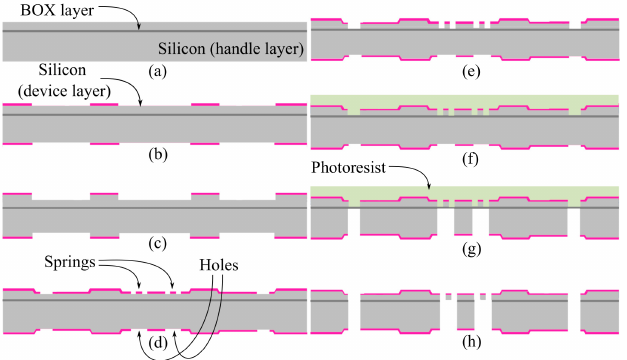
Figure 5. Fabrication process for the MEMS structures: ( a ) SOI wafer, ( b ) double-side alignment lithography, ( c ) device and handle DRIE process for the desired stiffness and mass weight, ( d ) lithog- raphy for the design of the springs in the device and proof mass design for the handle, ( e ) device etch for the spring machining, ( f ) device side structure protection with thick resist, ( g ) handle etch for the proof mass machining, and ( h ) BOX etch from the handle side before the resist